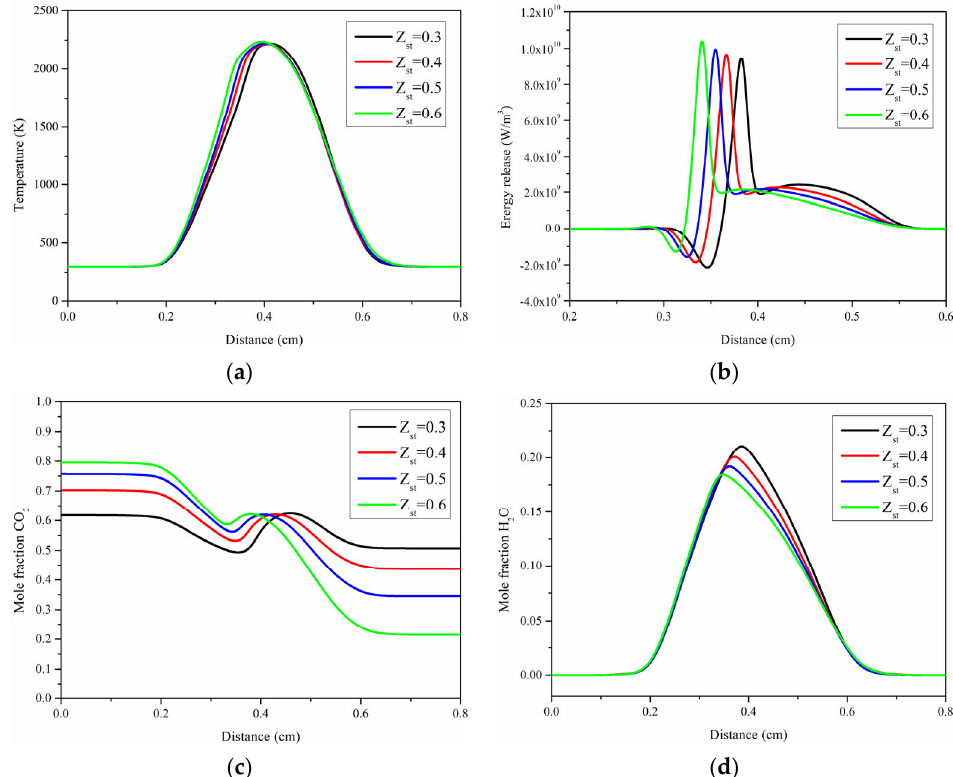
Figure 9. The distributions of temperature ( a ), heat generation ( b ), CO 2 mole fraction ( c ), and H 2 O mole fraction ( d ) in cases 2.1–2.4.